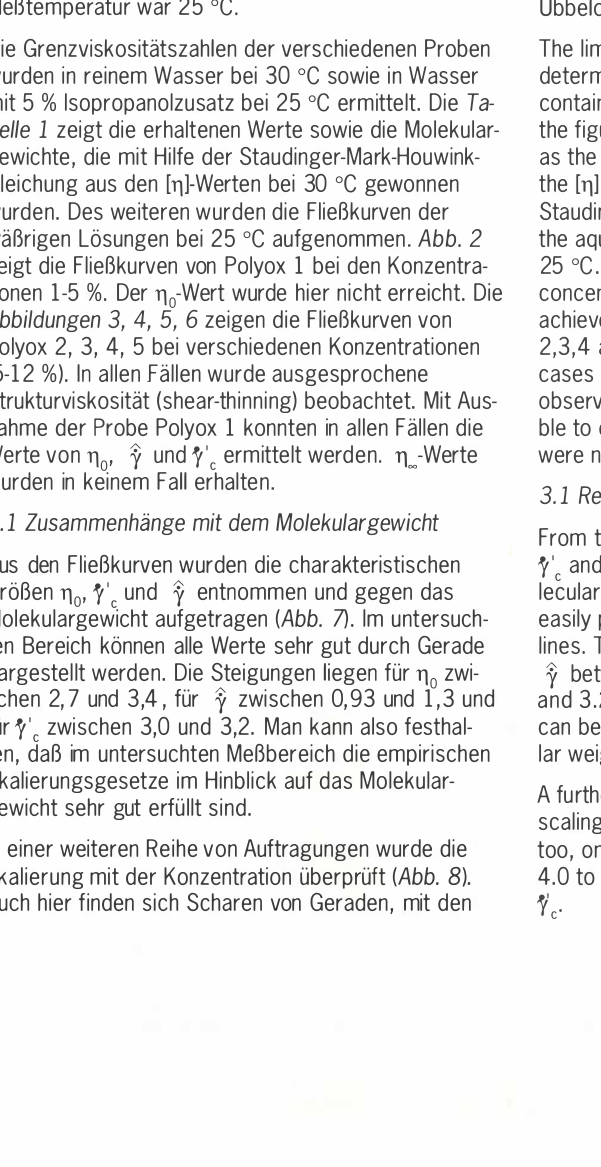
Fig. 8: Scaling laws for f\0, y and 1c V S.